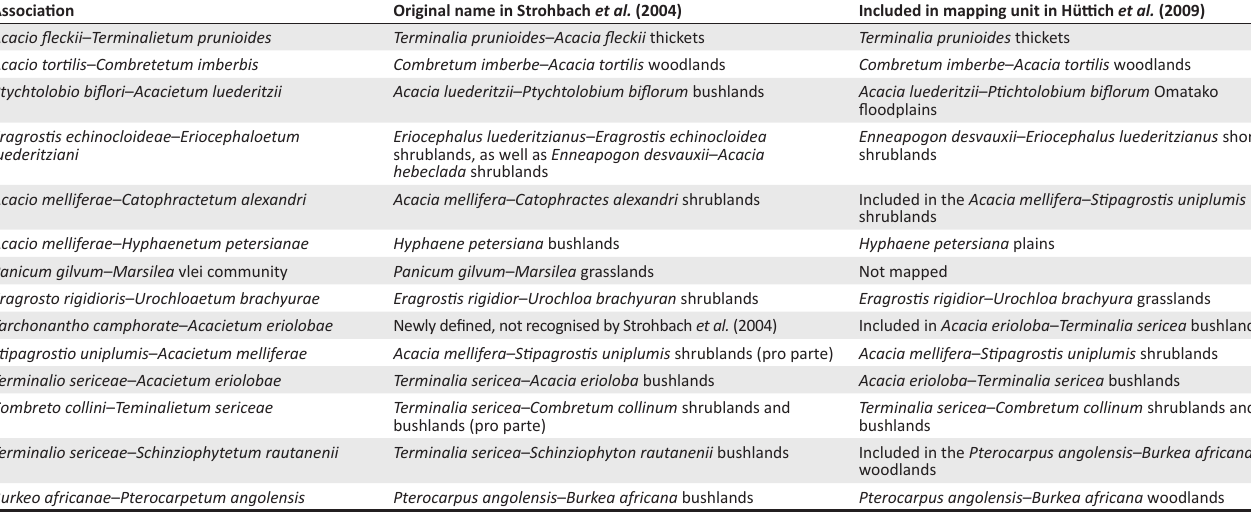
TABLE 1: Association names as used in the present study, as related to the community names used in the original 2004 study and the 2009 vegetation mapping